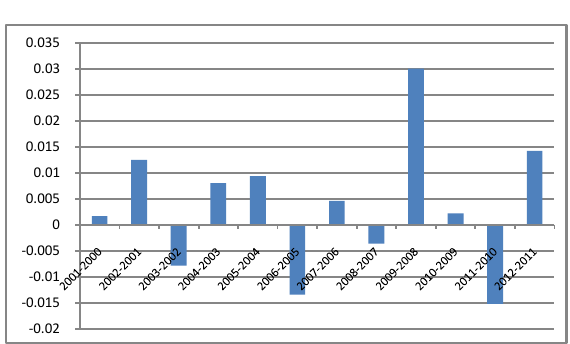
Figure 4. The change of average of annual maximum vegetation coverage during the period from 2000 to 2012 in Qinghai province